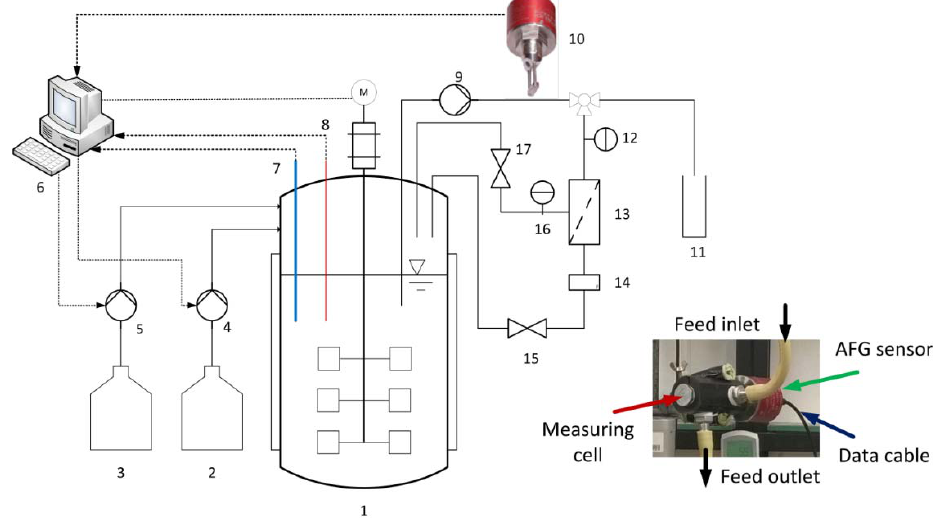
Figure 2. Dynamic measurement system for the characterization of the optical sensor and ceramic membranes: ( 1 ) stirred tank reactor, ( 2 ) base, ( 3 ) substrate, ( 4 , 5 ) peristaltic pumps, ( 6 ) control system, ( 7 ) pH probe, ( 8 ) temperature probe, ( 9 ) rotary vane pump, ( 10 ) optical sensor, ( 11 ) sample, ( 12 , 16 ) manometers, ( 13 ) membrane module, ( 14 ) miniature oval gear flow meter, ( 15 , 17 ) valves.